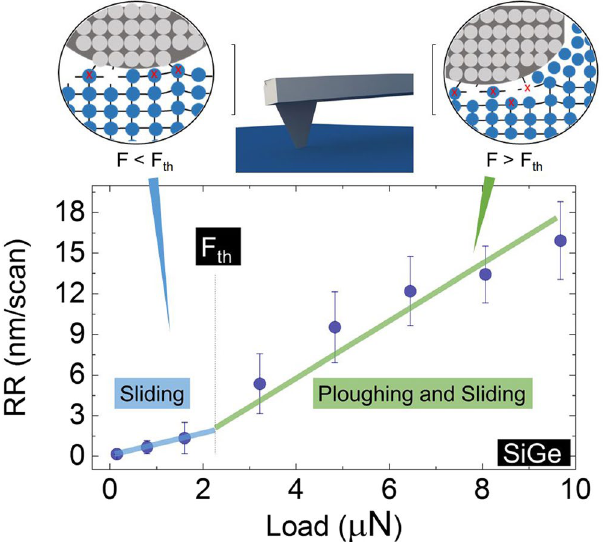
Figure 3. Two contact regimes are acting within the range of load forces investigated. The dependence of the removal rate on the tip load force for SiGe is shown with an added schematic representation of the two distinct contact mechanisms associated with different load